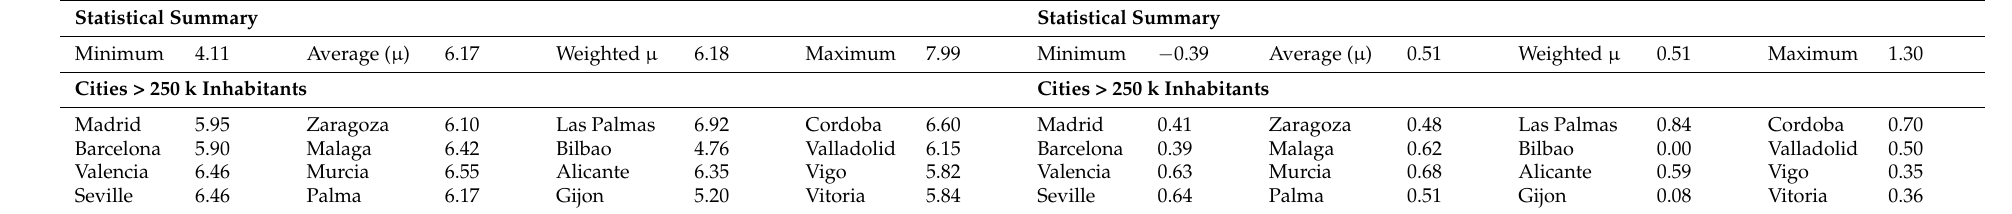
Figure A5. ST NPV in thousand euros (S3 (auxiliary electricity supply scenario) left , and S4 (auxiliary natural gas supply scenario) right ).